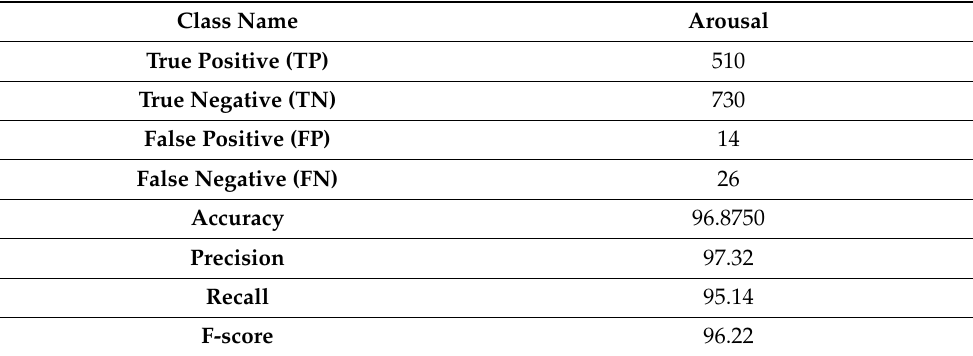
Figure 16. Confusion chart for Arousal label. Table 5. Arousal label results.